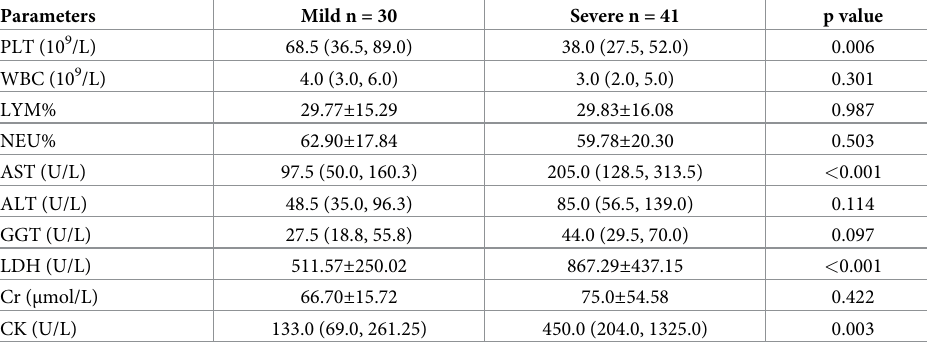
� LYM%, NEU%, LDH and Cr were described as (mean ± SD); PLT, WBC, AST, ALT, GGT and CK were described as median